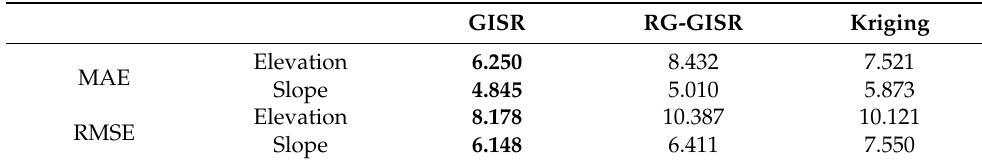
Table 2. The accuracy indicators of ablation experiments to remove different modules (GISR is a method in this paper, RG-GISR means removing the global information supplement module, Kriging as control method). GISR RG-GISR Kriging